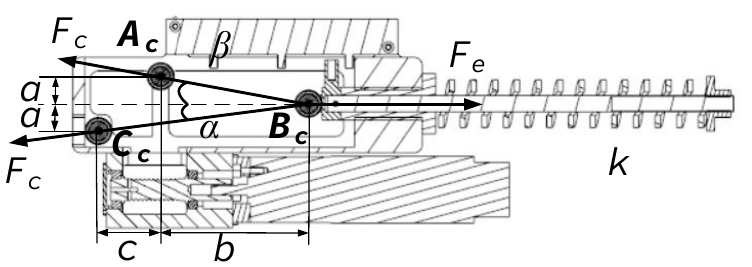
Figure 5. Force analysis of cable actuator.